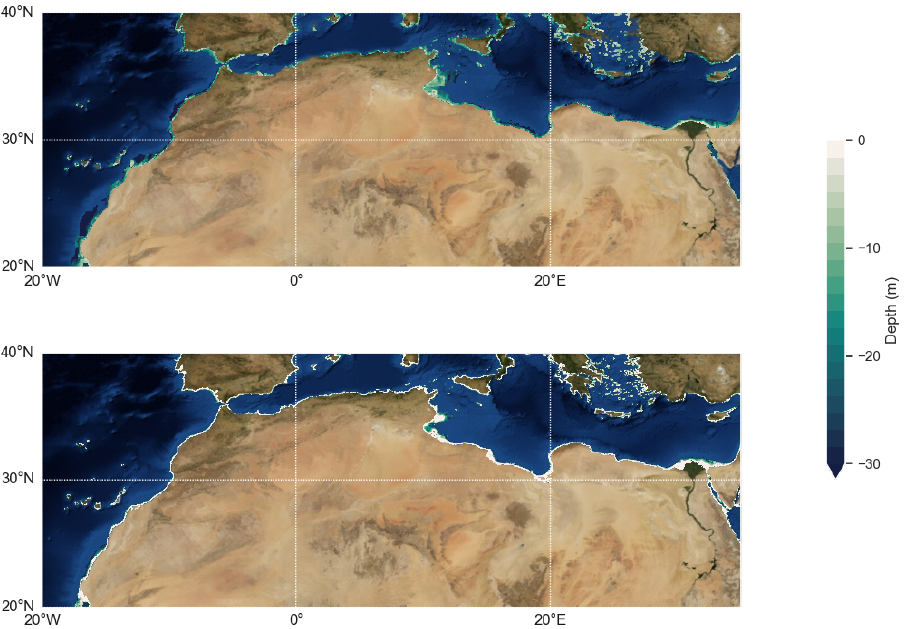
Figure 5. Bathymetry along the North Africa coastline with our S2 shores estimate at the top and the reference GEBCO global product